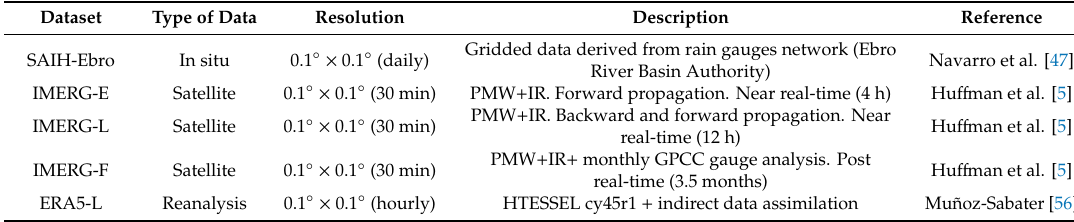
Table 2. Summary of datasets used in this